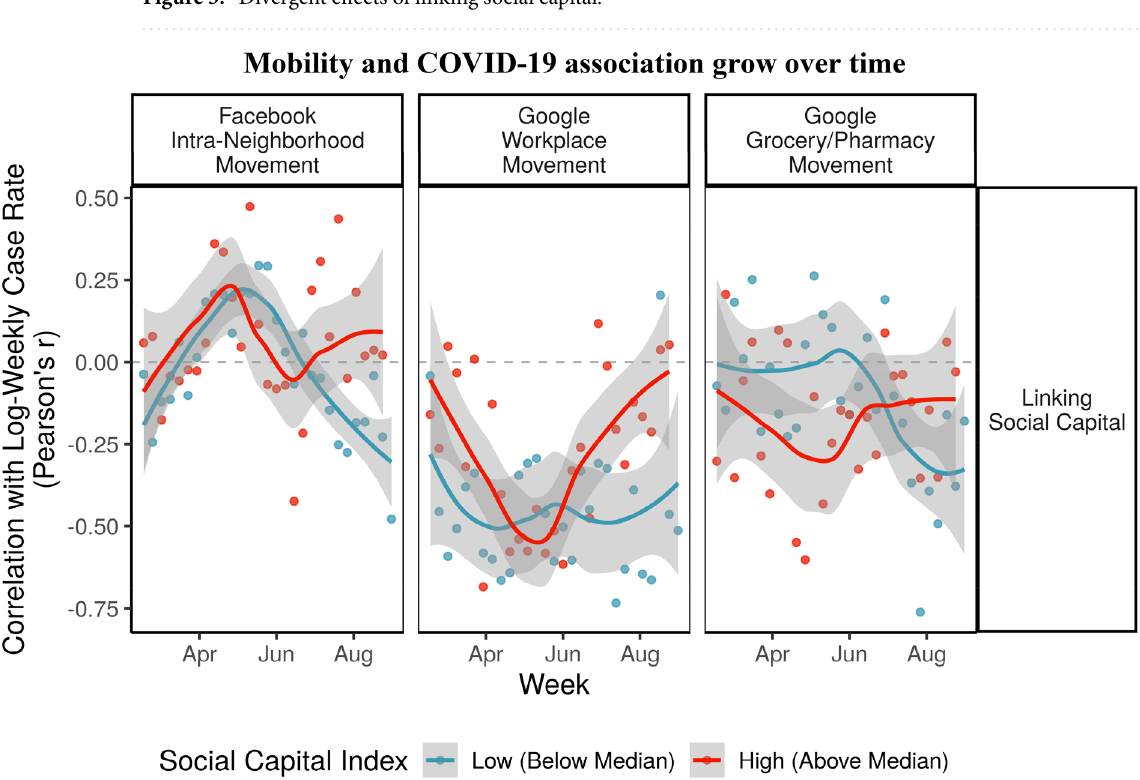
Figure 6. Prefectures with strong linking social capital see Mobility and COVID-19 association grow over